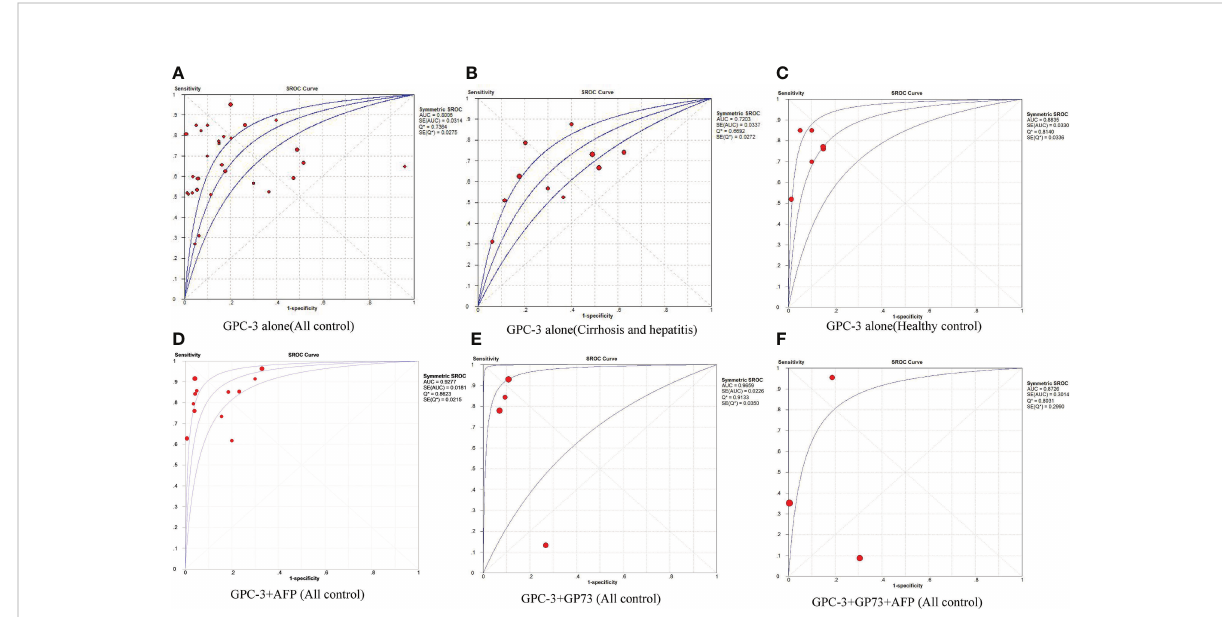
FIGURE 2 The pooled diagnostic accuracy of overexpression of GPC-3 alone in diagnosing HCC vs. all controls (A) , HCC vs. cirrhosis and hepatitis (B) , HCC vs. healthy control (C) , and combination diagnostic accuracy of GPC-3 + AFP (D) , GPC-3 + GP73 (E) , and GPC-3 + GP73 + AFP (F) in diagnosing HCC vs. all controls. AUC, area under the curve; GPC-3, Glypican-3; HCC, hepatocellular carcinoma; SROC, summary receiver operating characteristic